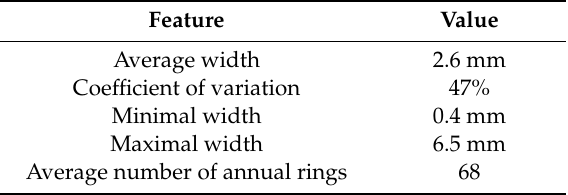
Table 2. Characteristics of annual growth (at the breast height) of birch debts.